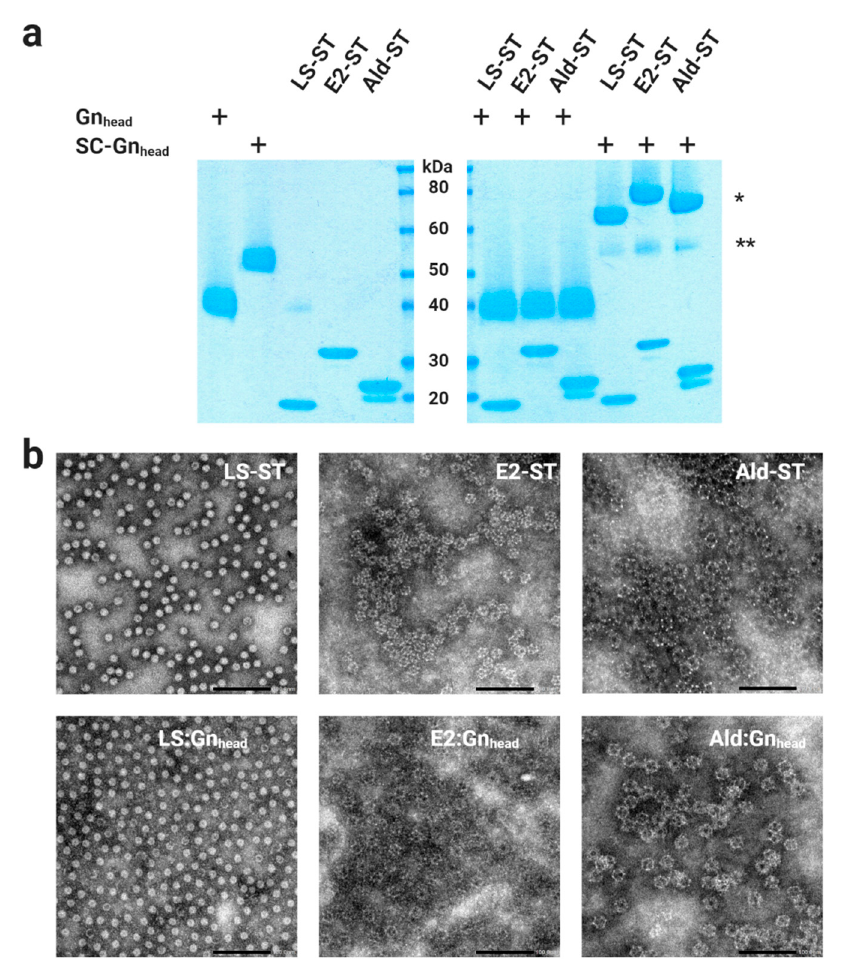
Figure 2. Confirmation of RVFV-Gn head coupling to MPSPs. ( a ) SDS-PAGE of purified Gn head and SpyCatcher-linked Gn head ; SC-Gn head . Purified MPSPs with C -terminally-linked SpyTags (ST) and LS-ST, E2-ST, and Ald-ST MPSPs mixed with either Gn head or SC-Gn head for 1 h at room temperature (RT) at a ratio just above particle saturation. Coupled MPSP-derived monomers (*) and remaining free antigen (**) is indicated. The lowest band in the Ald-ST lanes most likely represents a proteolytic degradation product. The plus sign means that Gn head or SC-Gn head was present in the sample ( b ) TEM images (negative stain) of the SpyTag-linked MPSPs with or without conjugated SC-Gn head antigen. Particles were uniformly dispersed and no evidence of aggregation was observed. The colon (:) represents coupling of antigen to MPSPs. Scale bar: 100 nm.